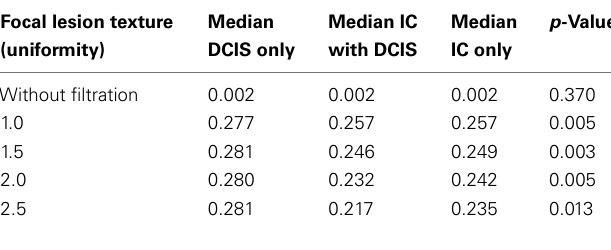
Table 2 | Median values for focal lesion texture (uniformity) between DCIS only, IC with DCIS and IC only along with the p -values obtained from the Kruskal–Wallis statistical test.